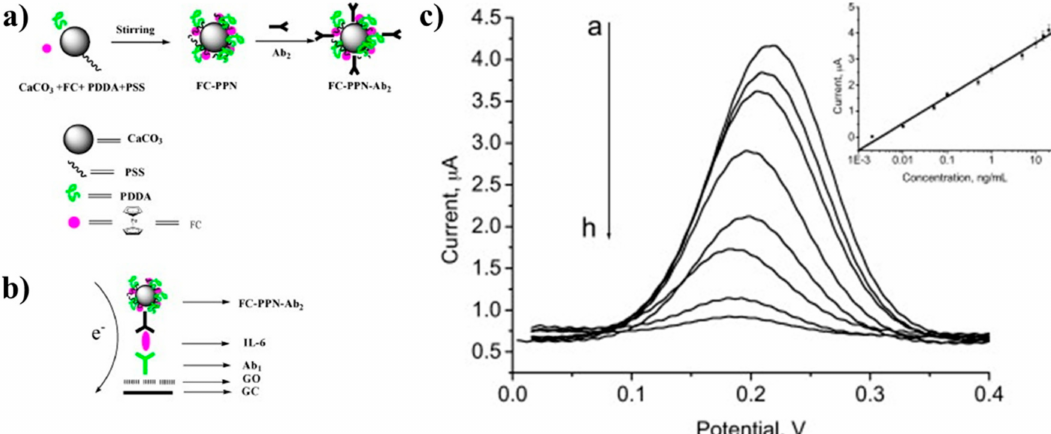
Figure 9. ( a ) Schematics of the fabrication of ferrocene loaded porous polyelectrolyte nanoparticles–Ab2 and ( b ) the immunosensor. ( c ) SWV response of the immunosensor towards different concentrations of interleukin–6 (0.01–20 ng/mL). Scanning the potential window was from 0–0.4 V with a frequency of 25 Hz using a 5–mV potential step and 25 mV amplitude. The insert is the corresponding calibration curve. Reproduced with permission from reference [49]. Copyright © 2020 Elsevier B.V.